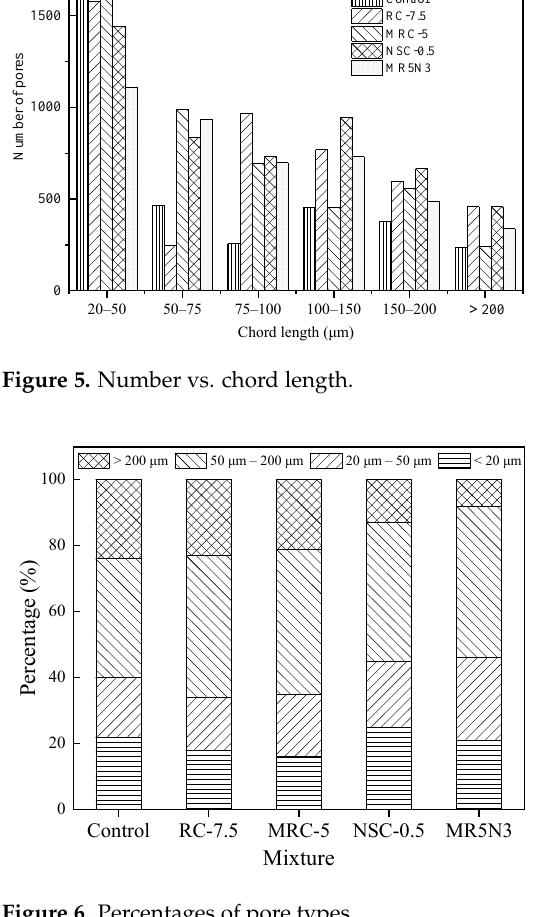
Mixture Figure 7. Specific surface area of pores.